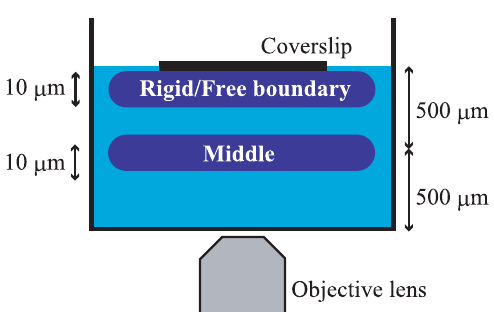
Fig. 1 Three observed layers in the bacterial suspension. The liquid-air interface was employed as a free boundary. A piece of coverslip was put on the interface to make a rigid boundary. The thickness of each layer was ∼ 10 µ m, corresponding to the practical depth of focus of the objective